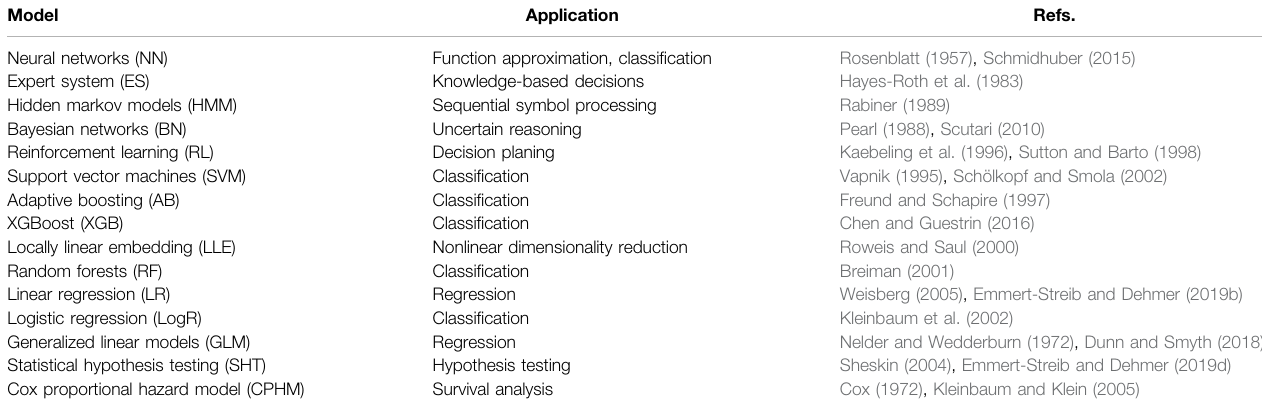
TABLE 1 | List of popular, core arti fi cial intelligence, machine learning and statistics methods representing characteristic models of those fi elds.